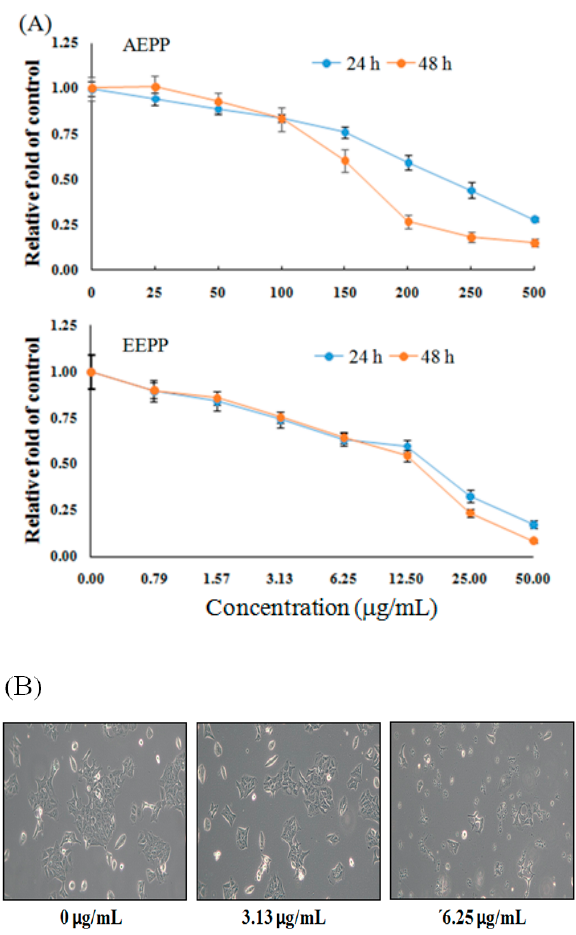
Figure 1. Inhibitory effect of Paris polyphylla on colorectal cancer cells. ( A ) Inhibitory effect of aqueous extract of P. polyphylla (AEPP) or ethanolic extract of P. polyphylla (EEPP) on DLD-1 colorectal carcinoma cells after treatment for 24 and 48 h, respectively. Data are shown as means ± SD ( n = 3). ( B ) The morphological appearance of DLD-1 colorectal carcinoma cells after 24 h of EEPP treatment. 2.2. EEPP Treatment Causes Autophagic Cell Death in Colorectal Carcinoma Cells